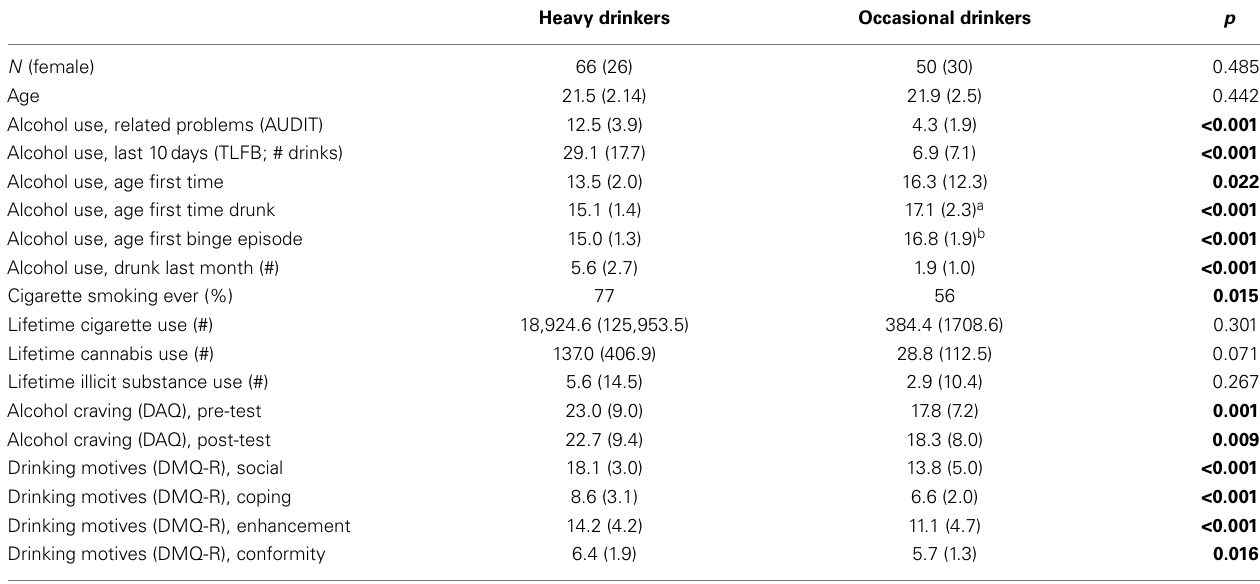
Table 1 | Sample characteristics